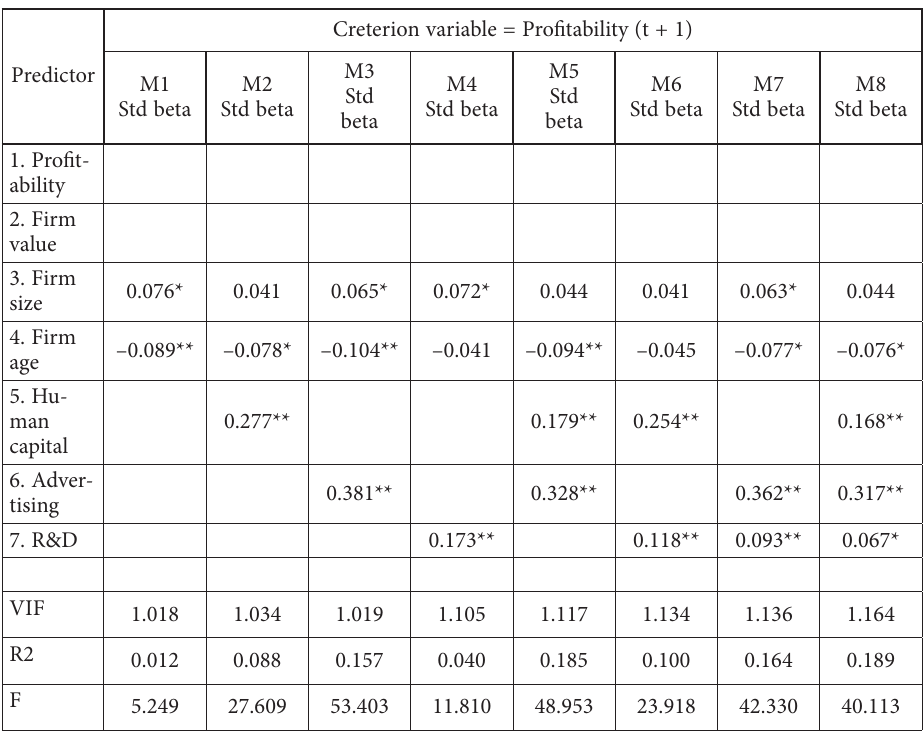
Table 4. Regression results on